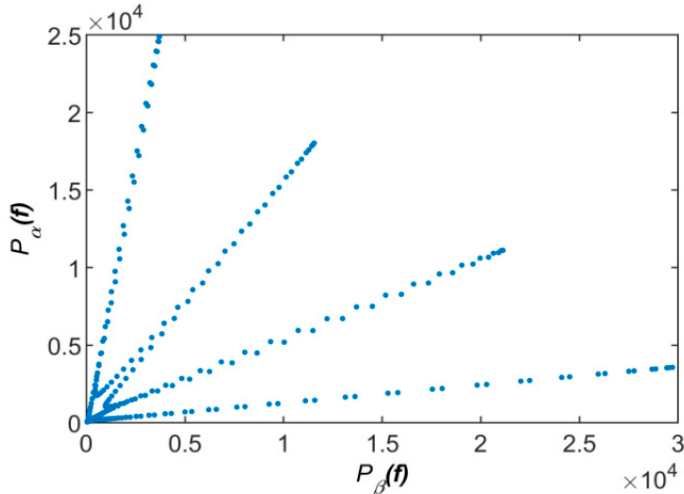
Figure 1. The power scatters of mixed signals without TF aliasing.